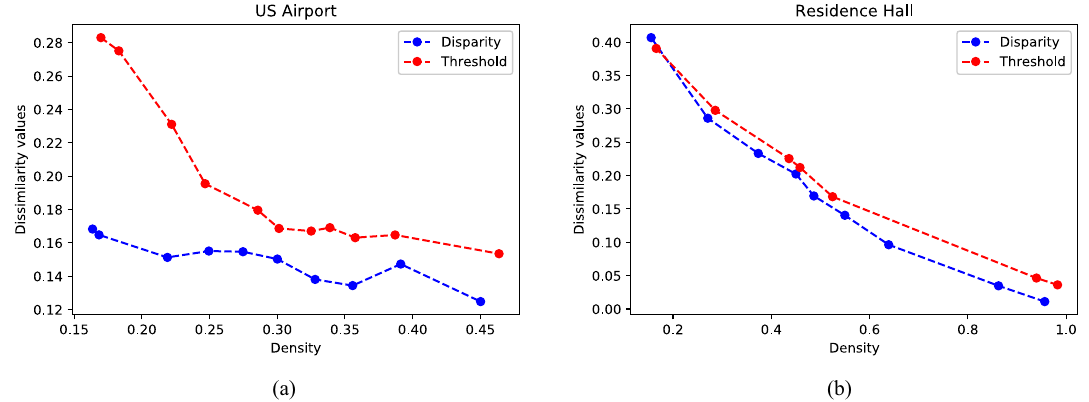
Figure 6. D-values between the filtered backbones and the original networks. ( a ) For the U.S. Airport. ( b ) For the Residence Hall. The abscissa represents the edge density proportion of extraction backbone to the original